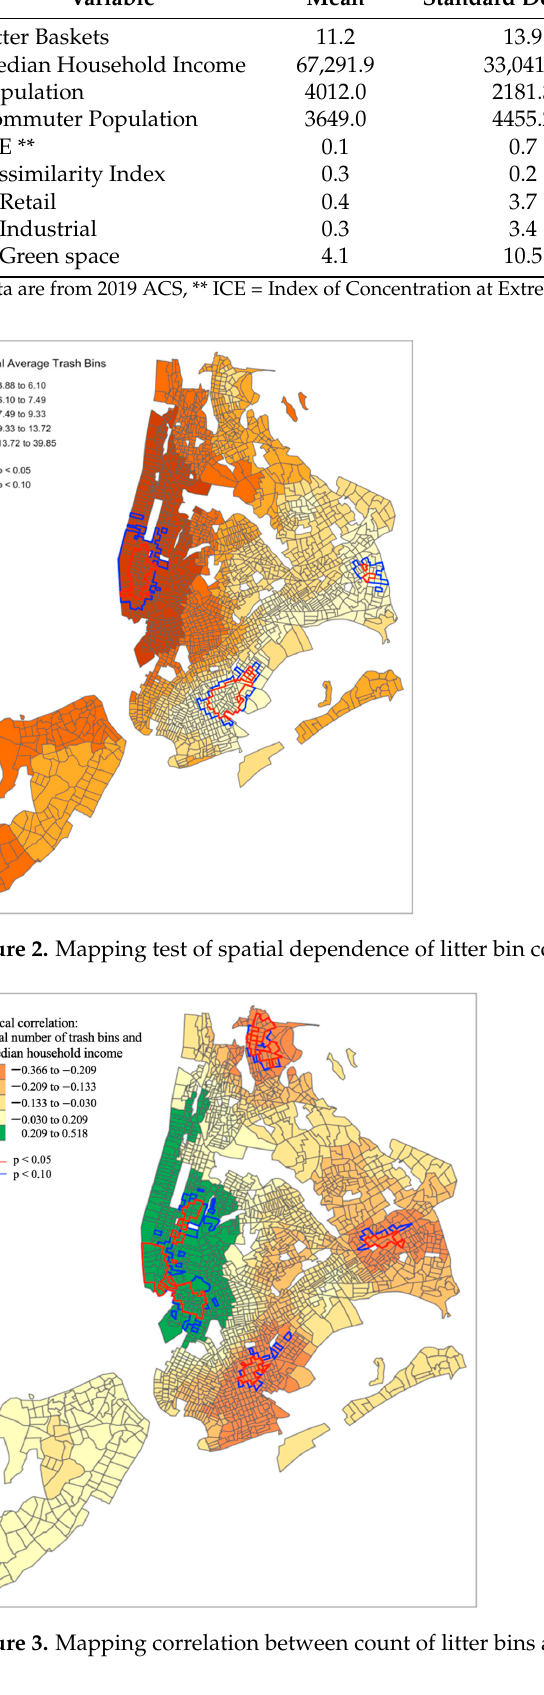
Figure 2 depicts the spatial dependence of litter bin count by census tract in NYC.